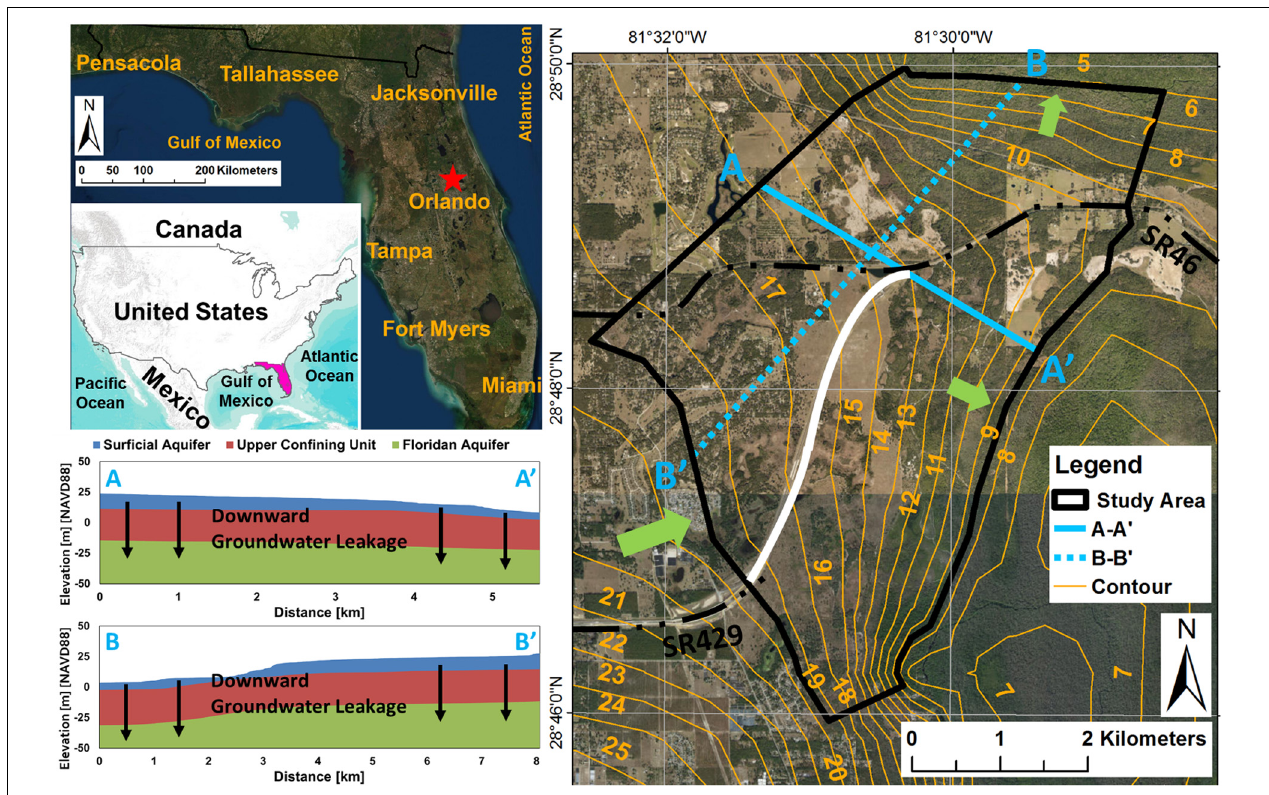
FIGURE 1 | Location of the study area and cross-sections A–A’ and B–B’ showing the hydrostratigraphic units (the bottom of the Floridan aquifer is much deeper than − 50